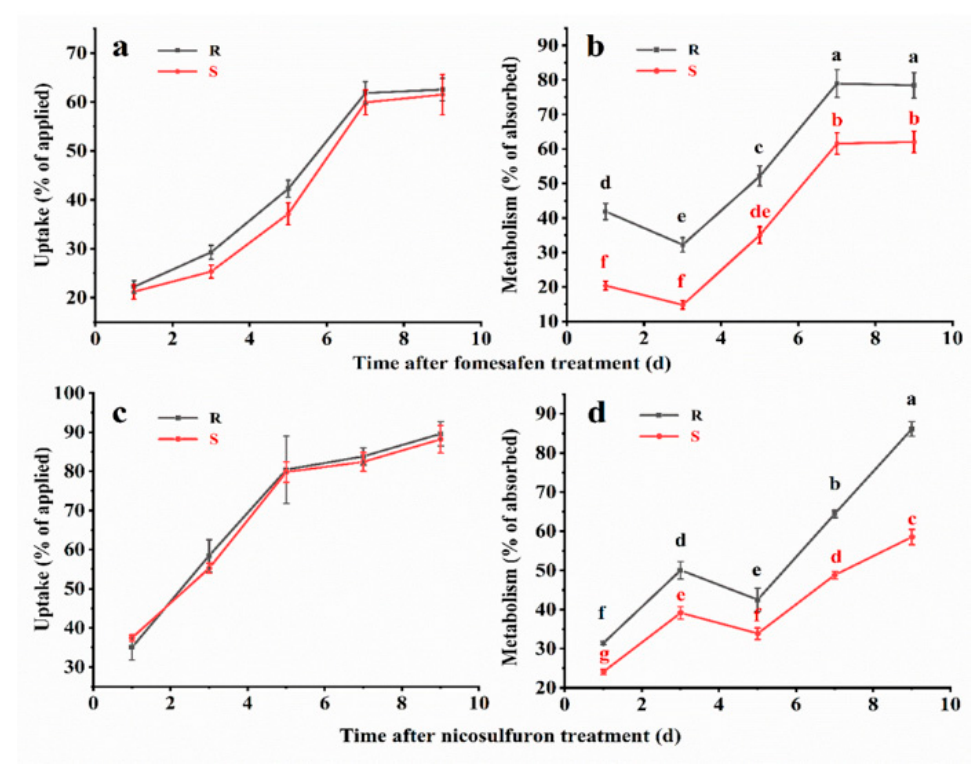
Figure 5. Herbicides uptake in the HW-01 population (R) and ST-1 population (S). Amaranthus retro fl exus L. plants at 1, 3, 5, 7 and 9 d after herbicides treatment (DAT) (( a ) Fomesafen, ( c ) Nicosulfuron). Herbicides metabolism rate in the R and S plants at 1, 3, 5, 7, and 9 DAT (( b ) Fomesafen, ( d ) Nicosulfuron). Di ff erent le tt ers under the same herbicide treatment indicate signi fi cant di ff erences in metabolism at the p < 0.05 level according to Fisher’s protected least signi fi cant di ff erence (LSD). Table 5. Analysis of metabolic dynamics of fomesafen in A. retro fl exus plants.